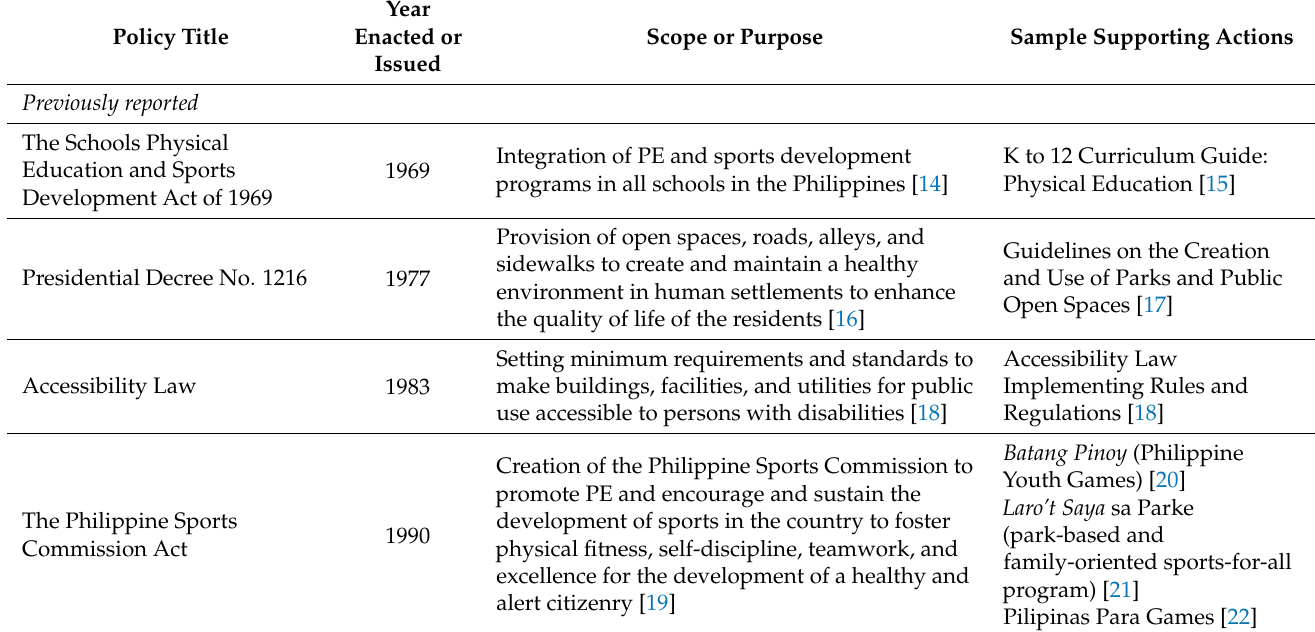
Table 4. Summary of physical activity promoting policies in the Philippines 1